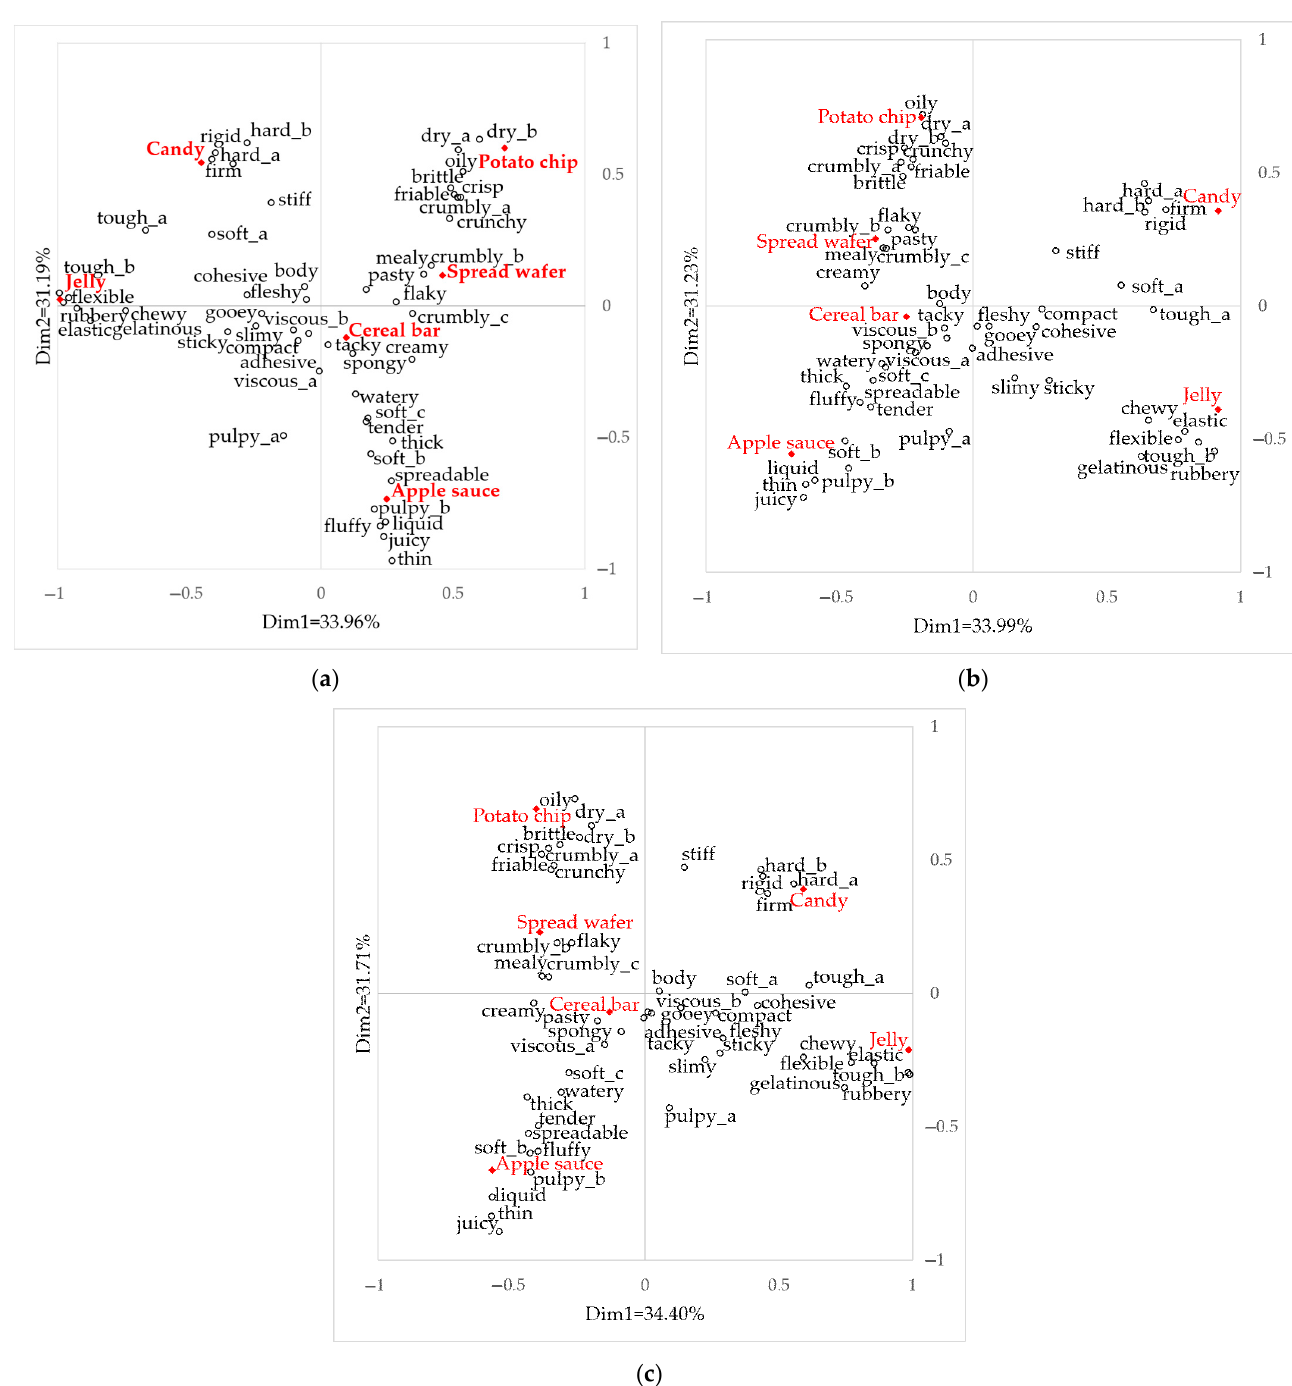
Figure 3. Correspondence analysis biplots using 51 texture attributes from the ( a ) ‘No control’, ( b ) ‘Order control’, and ( c ) ‘Time and order control’ groups. A total of 51 attributes were provided for CATA, Rhombus ( ◆ ) indicates samples.